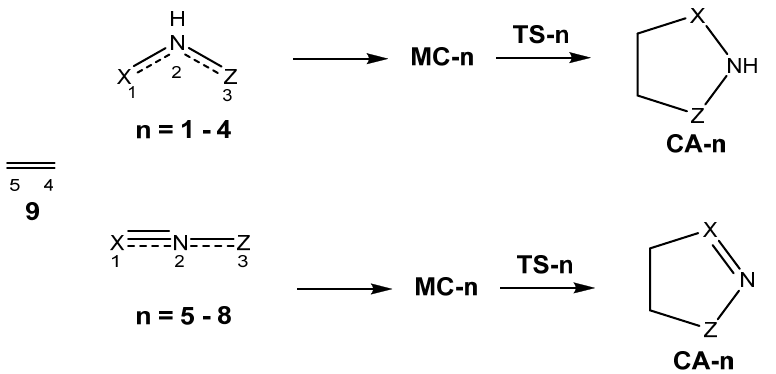
Figure 3. 3D representation of the Mulliken atomic spin density maps of radical cations ( 1–8 ) ·+ and radical anion 10 · − together with the nucleophilic 𝑃 (cid:3038)(cid:2879) Parr functions of TACs 1–8 and the electrophilic 𝑃 (cid:3038)(cid:2878) Parr functions of DCE 10 .